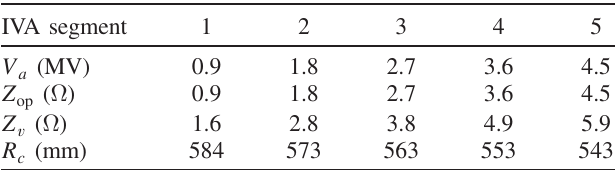
TABLE II. Parameters of IVA segments. The anode radius R 600 mm. The radius of the cathode segment is decreasing to accommodate impedance increasing. The operation impedance at the final cavity in each cavity group was matched to